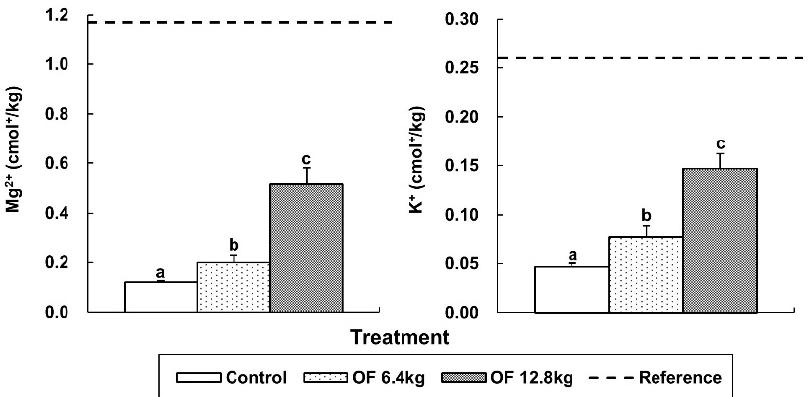
Figure 4. Effect of organic fertilizer as a soil ameliorator on soil characteristics. Control: fresh coal mine debris plot, OF 6.4 ton: plot ameliorated treating organic fertilizer of 6.4 ton/ha, OF 12.8 ton: plot ameliorated treating organic fertilizer of 12.8 ton/ha, Reference: natural forest soil. Each bar is expressed as the mean and standard error of mean. Tukey’s honestly significant difference (HSD) test was conducted on each of the parameters that showed a statistically significant difference among the three types of treatments at α = 0.05; the means with the same alphabetical character (in superscript) for each parameter are not different from each other.